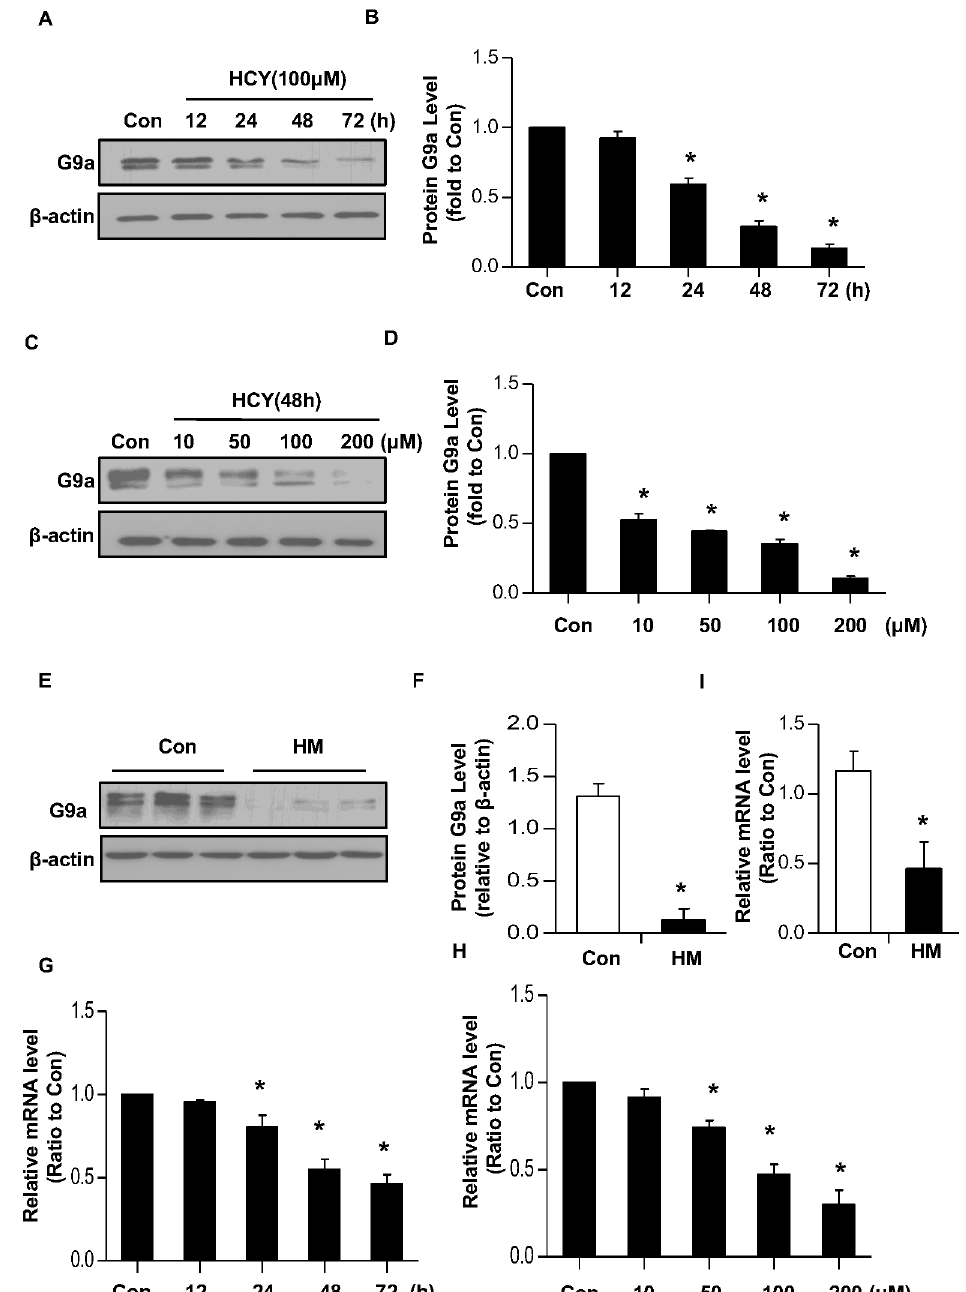
Fig 6. Homocysteine decreases G9a expression both in vitro and in vivo . LO2 cells were incubated with 100 μ M of Hcy for indicated time period (A-B), or indicated concentration of Hcy for 48 h (C-D). The protein level of G9a was determined by Western blotting. β -actin was used to verify equivalent loading. Graphic representation of relative protein level of G9a normalized to β -actin (B, D). Data are mean ± SD of three independent experiments. * p < 0.05 versus control cells. (E) Liver tissues of HHcy mice were collected from HHcy mice or control mice fed with regular rodent chow. The protein level of G9a in liver was determined by Western blotting. β -actin was used to verify equivalent loading. (F) Graphic representation of relative protein level of G9a normalized to β -actin. (G-H) LO2 cells were incubated with 100 μ M of Hcy for indicated time period (G), or indicated concentration of Hcy for 48 h (H). The mRNA level of G9a was determined by real time PCR. (I) Liver tissues were collected from HHcy mice or control mice fed with regular rodent chow. The mRNA level of G9a in the liver was determined by real time PCR. Data are expressed as mean ± SD, n = 6. * p < 0.05 versus control mice fed with regular rodent chow.